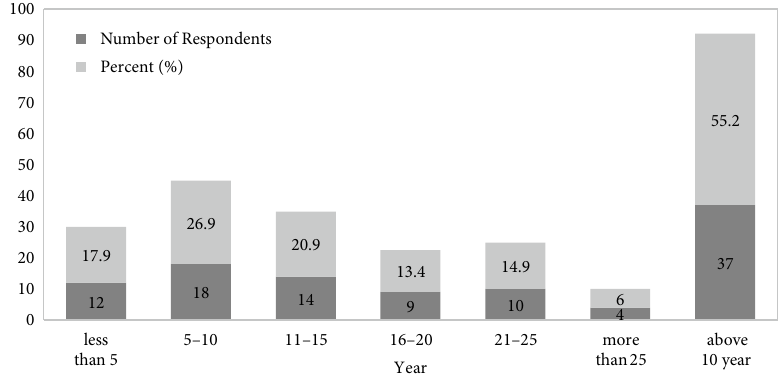
Figure 2. Number of participants and years of experience for the surveyed